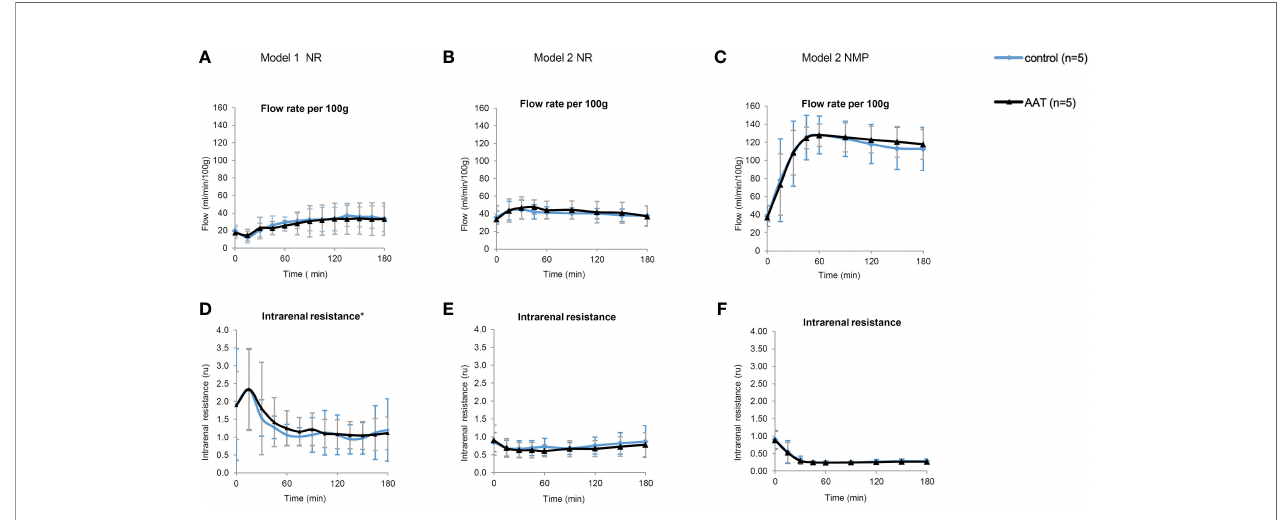
FIGURE 2 | Perfusion parameters including fl ow rate (ml/min/100 g) and intrarenal resistance (ru). (A – C) represent fl ow rate, and (D – F) represent intrarenal resistance during the normothermic reperfusion phase (NR) in models 1 and 2 as well as during the nomothermic machine perfusion preservation (NMP) phase in model 2, respectively. All results are shown as mean ± SD. *One data point (t = 15 min) in the graph (D) is excluded due to a technical error in the